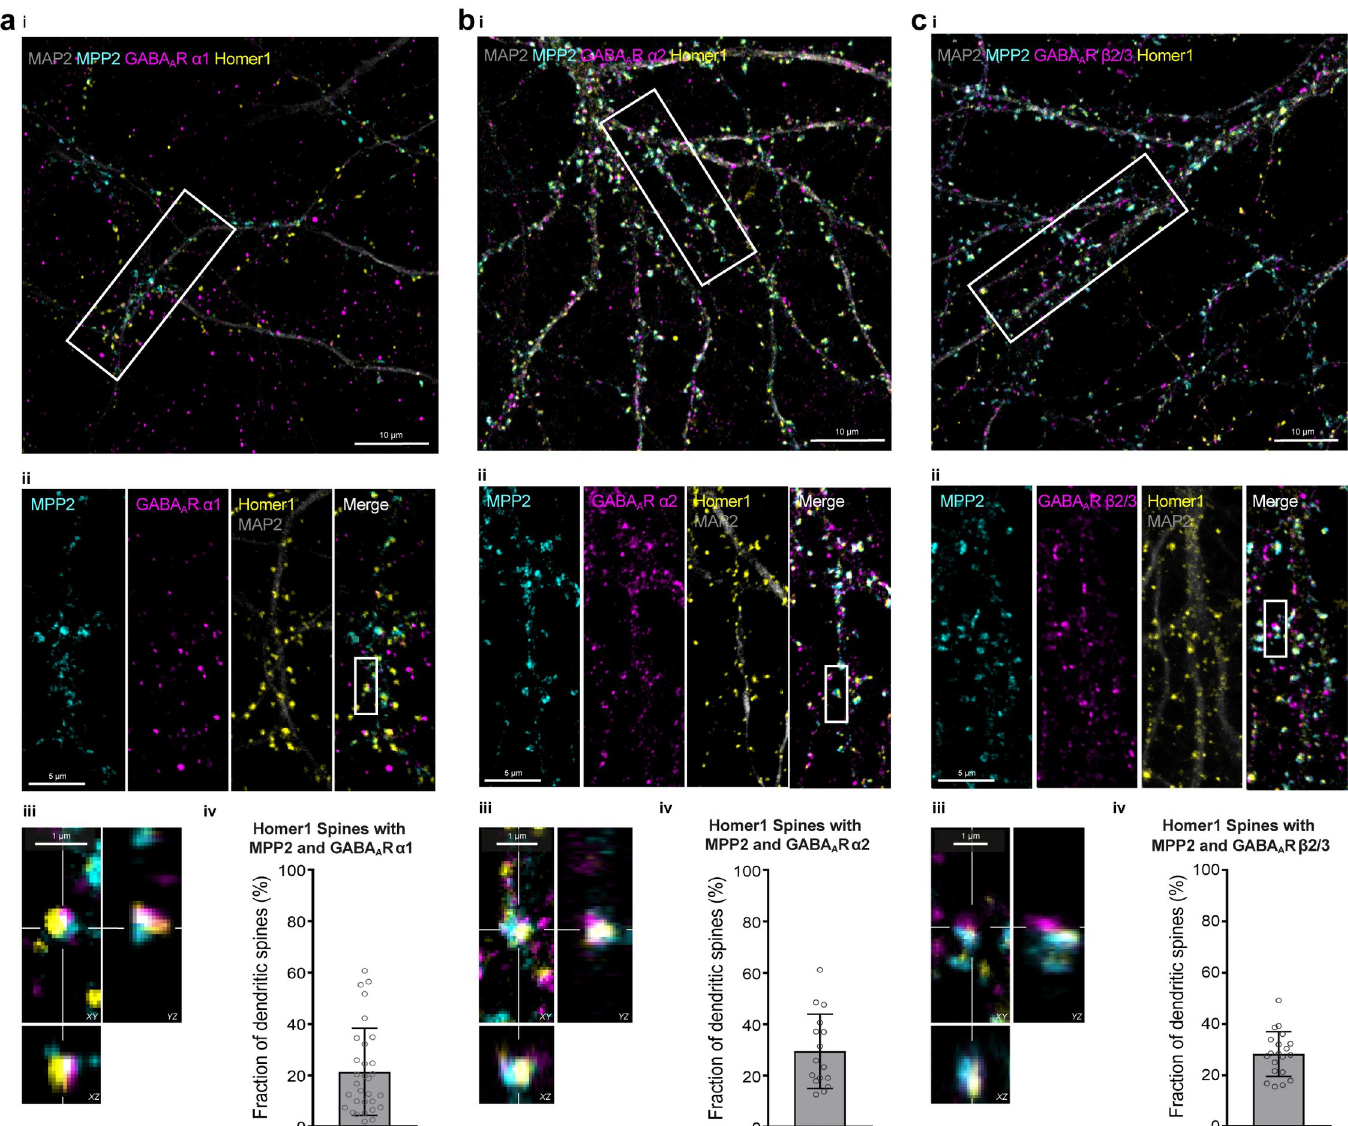
Fig 7. GABA A R subunits colocalise with MPP2 in a subset of dendritic spines. Primary E18 rat hippocampal neurons were fixed at DIV21 and immunostained for the endogenous proteins MAP2 (microtubule-associated protein 2, grey), MPP2 (cyan), and Homer1 (yellow) together with either (a) GABA A R α 1, (b) GABA A R α 2, or (c) GABA A R β 2/3 (all magenta) using respective primary and Alexa fluorophore-coupled secondary antibodies, and visualised by confocal microscopy. (i) Maximum projected overview of primary to secondary dendrite branches. Box indicates location of detail image in ii. Scale bar: 10 μ m. (ii) Maximum projection composite of 4-colour confocal immunofluorescence image of a primary to secondary dendrite branch point of a mature (DIV21) hippocampal neuron. MPP2 is located in the majority of dendritic spines marked with Homer1, while GABA A R subunits colocalise with a subset of these spines. Additionally, solely GABA A R α 1-, α 2- or β 2/3- positive puncta likely represent inhibitory synapses at the dendrite. Box indicates location of detail image in iii. Scale bar: 5 μ m. (iii) Enlarged single plane image with corresponding orthogonal views of a dendritic spine exhibiting immunofluorescence staining for Homer1, MPP2, and GABA A R α 1, α 2 or β 2/3, respectively. Scale bar: 1 μ m. (iv) Quantification of the fraction of excitatory synapses marked by Homer1, which also show MPP2 expression together with GABA A R α 1, α 2, or β 2/3 immunofluorescence. Please see Materials and methods for details. (mean ± SD; n = 16–31 images from N = 3 to 4 independent experiments). Underlying data can be found in S2 Data. DIV, days in vitro; GABA, γ -aminobutyric acid; MPP2, membrane protein palmitoylated 2.